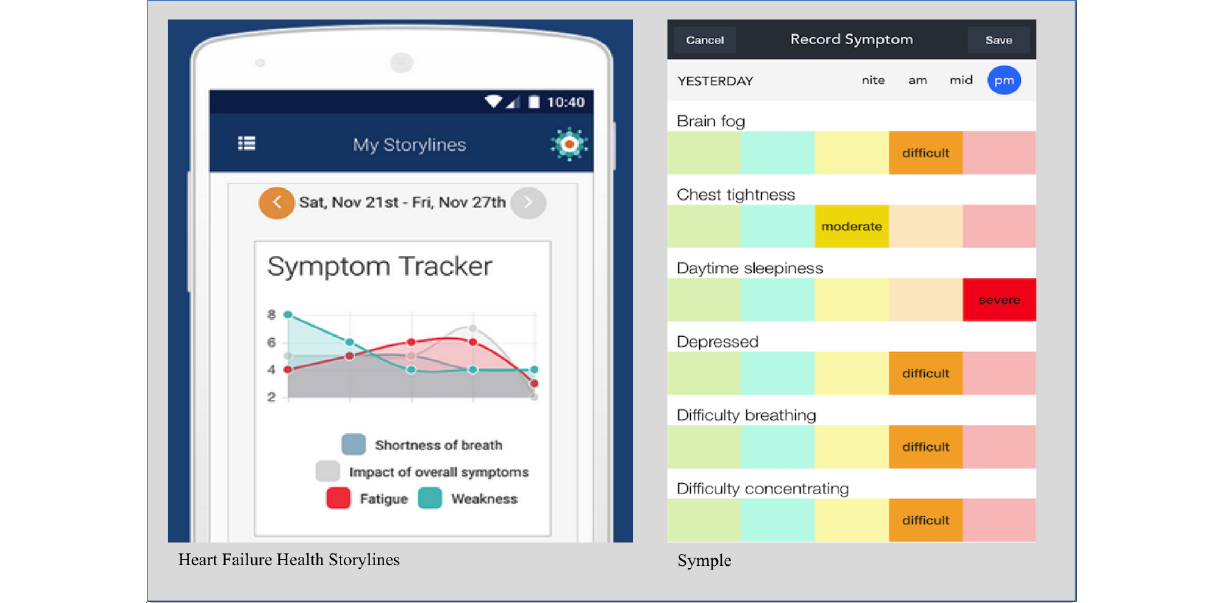
Figure 3. Symptom tracking features. Heart Failure Health Storylines (left image) enables tracking symptoms over time and Symple (right image) enables reporting symptoms for a single day and visualization of individual graphs by